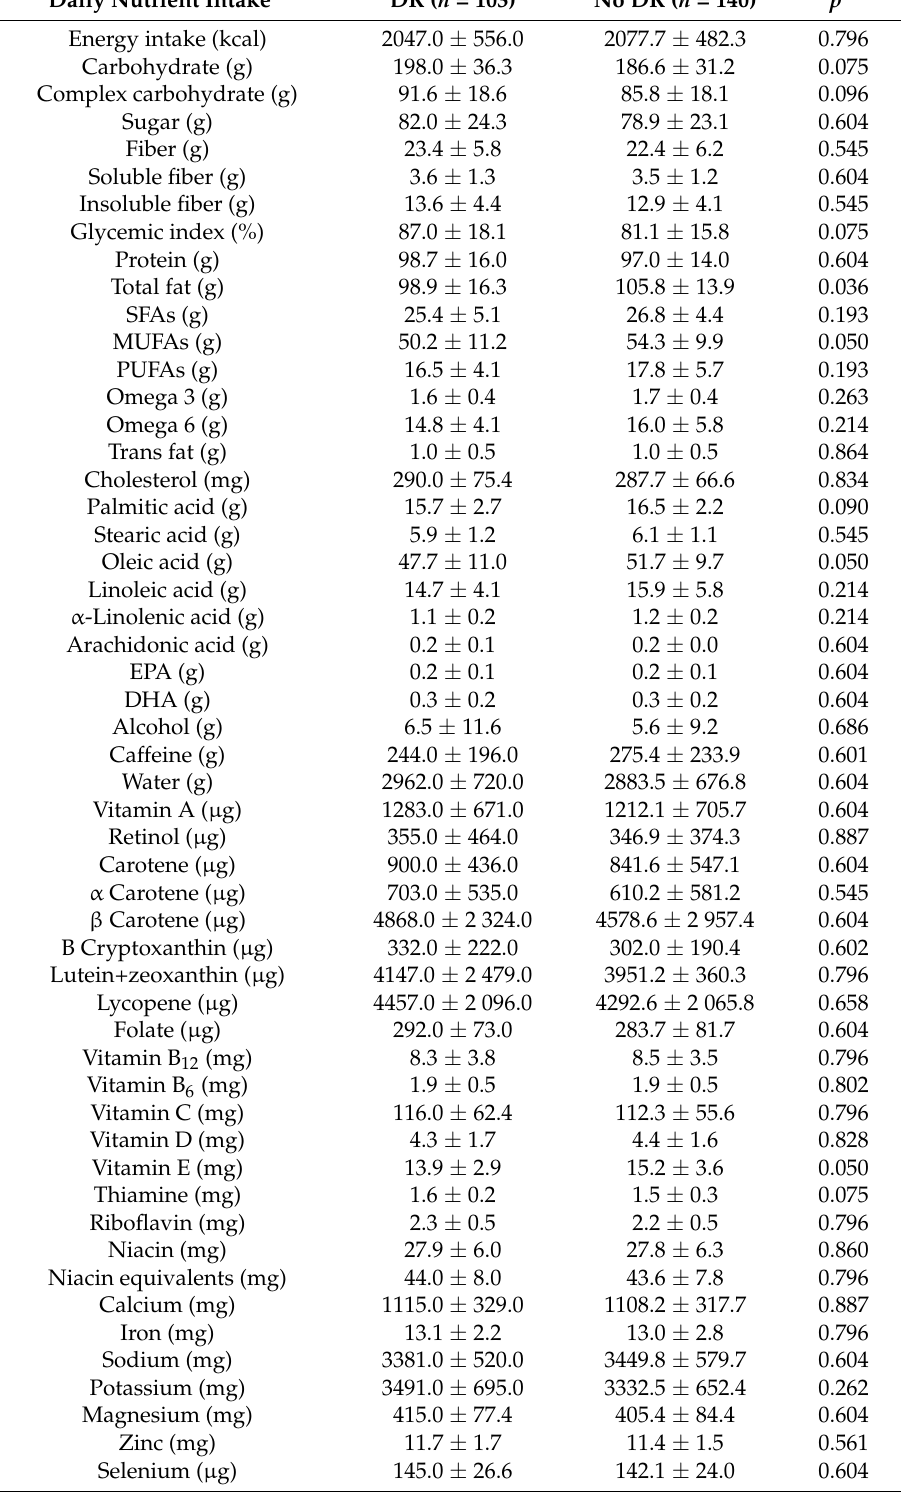
Table 2. Daily nutrient intake of participants according to diabetic retinopathy